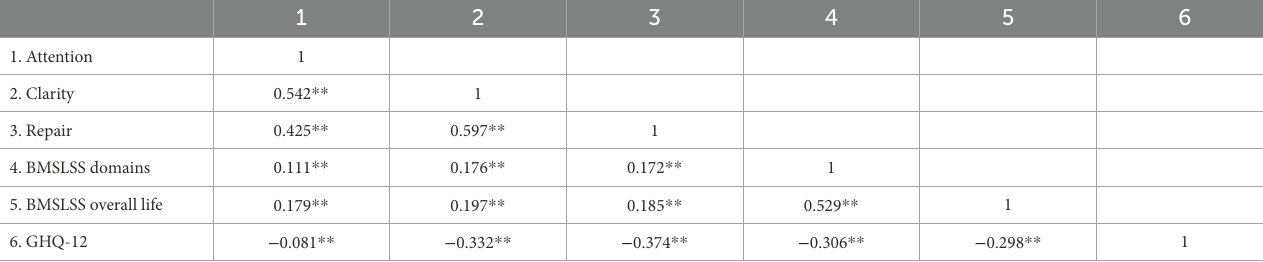
TABLE 5 Correlations between the means of the three dimensions of TMMS-24 and the BMSLSS and the GHQ-12 (RS, 2013–2018; n =